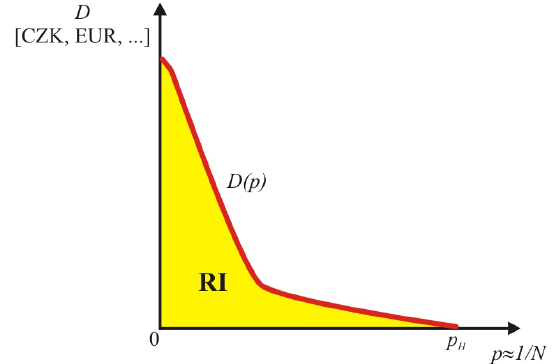
Fig. 3. Scheme of a flood loss exceedance curve D(p) .